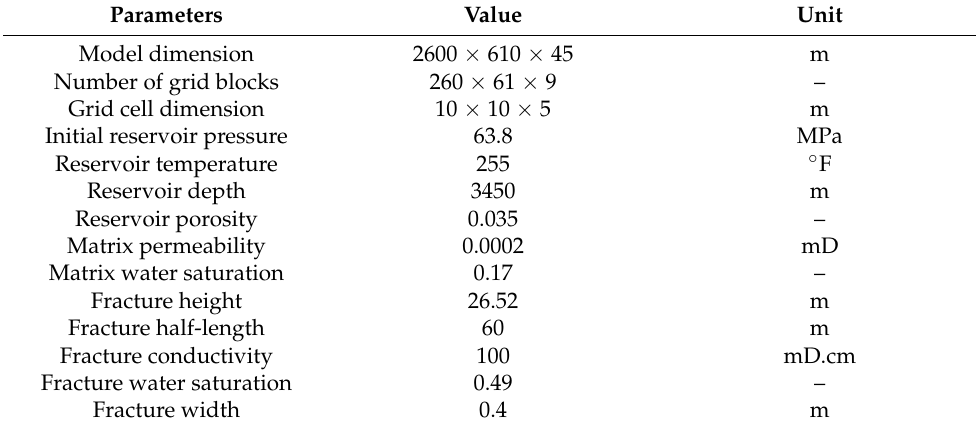
Figure 3. Comparison of well performance between raw data and model results: ( a ) Bottomhole Pressure; ( b ) Oil Rate; ( c ) Gas Rate. Table 5. Basic reservoir and fracture properties used for history